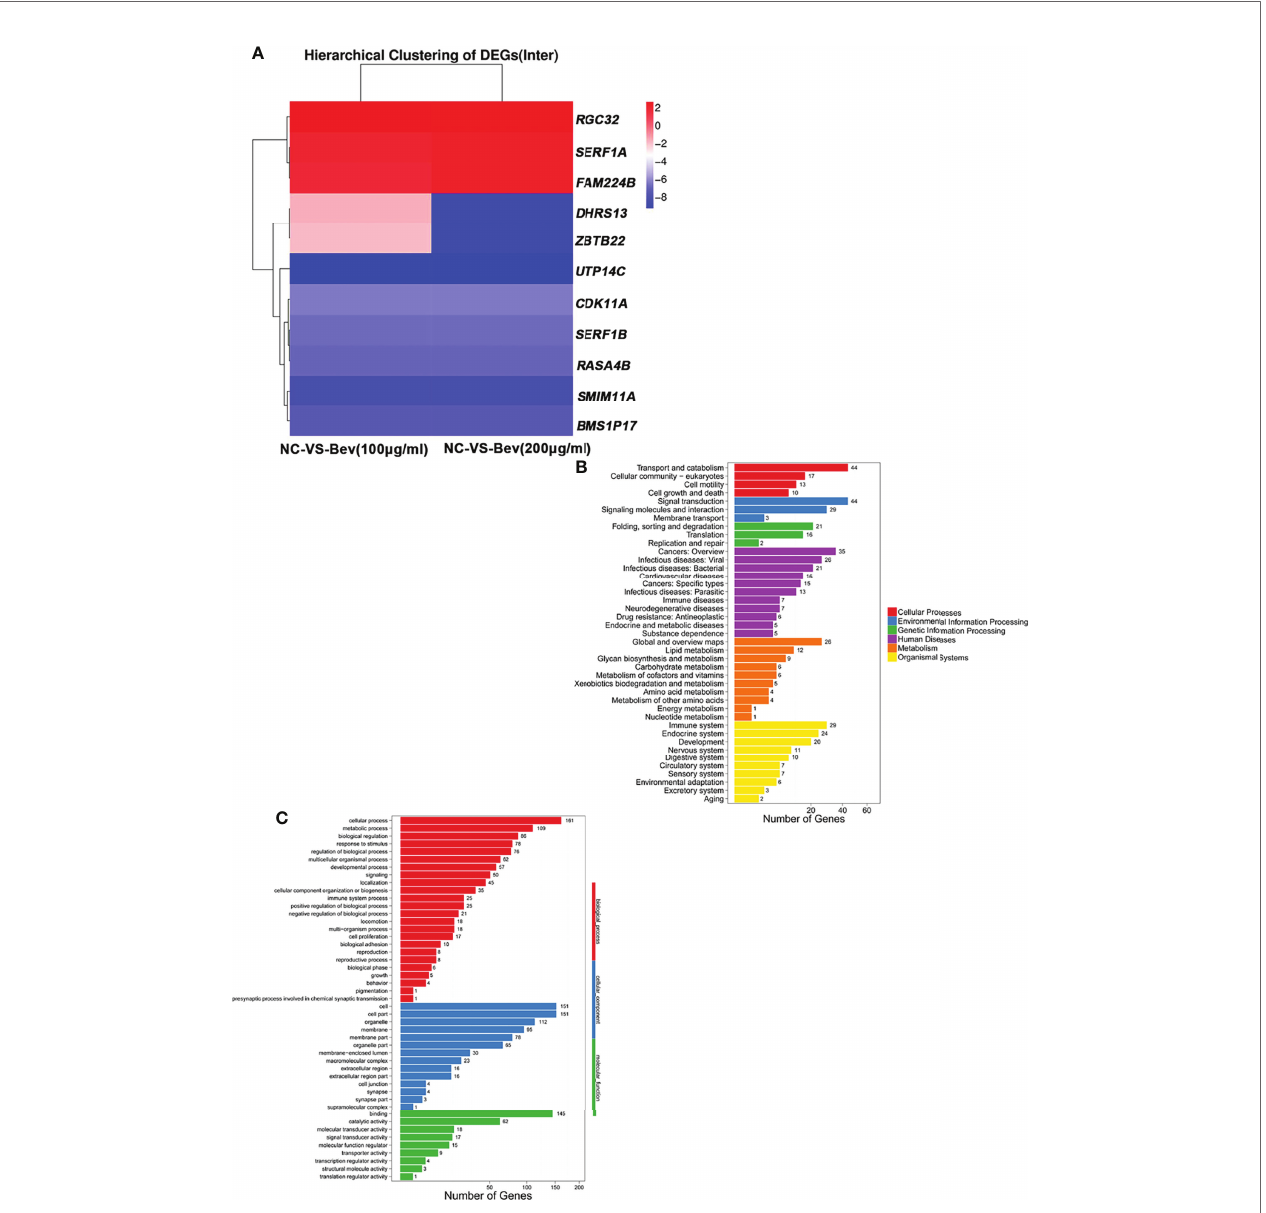
FIGURE 2 | Transcriptome analysis of differentially expressed genes induced by bevacizumab. (A) Heat map representation of differentially expressed genes in A549 cells in the control (NC), 100 m g/mL bevacizumab-treated and 200 m g/mL bevacizumab-treated groups. Red color represents gene upregulation and blue color represents gene downregulation. (B, C) GO analysis and KEGG pathway enrichment analysis of the differentially expressed genes in A549 cells after bevacizumab